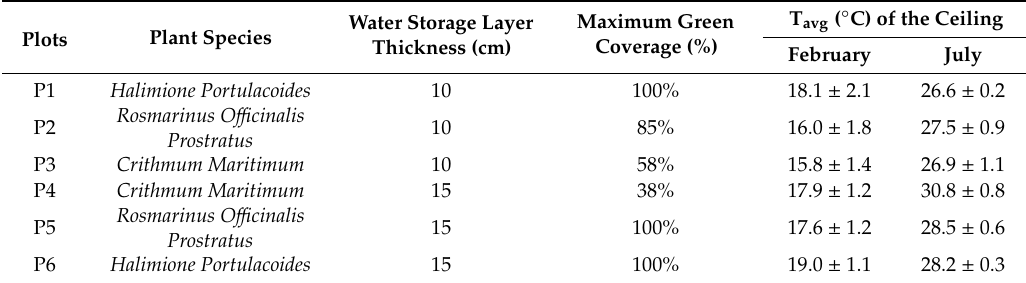
Table 3. Monitoring results of the green roofs six